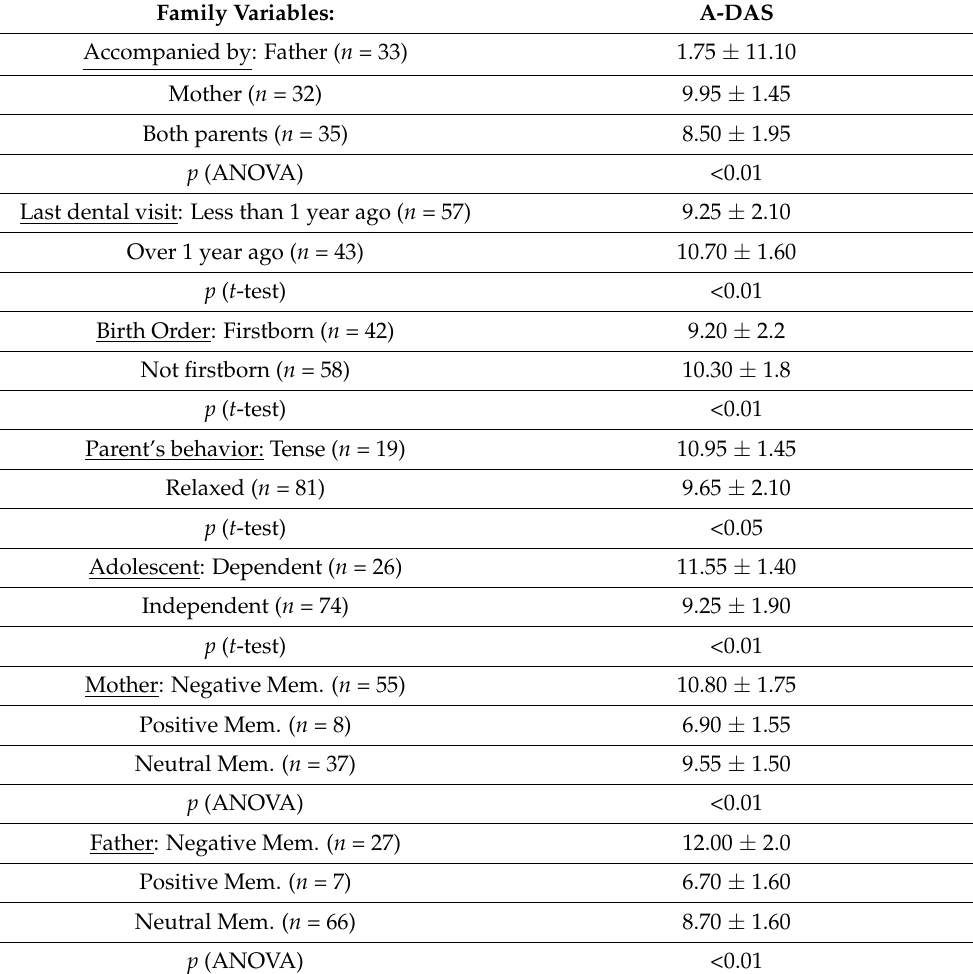
Table 2. Adolescent’s dental anxiety (A-DAS) according to family variables. Family Variables: